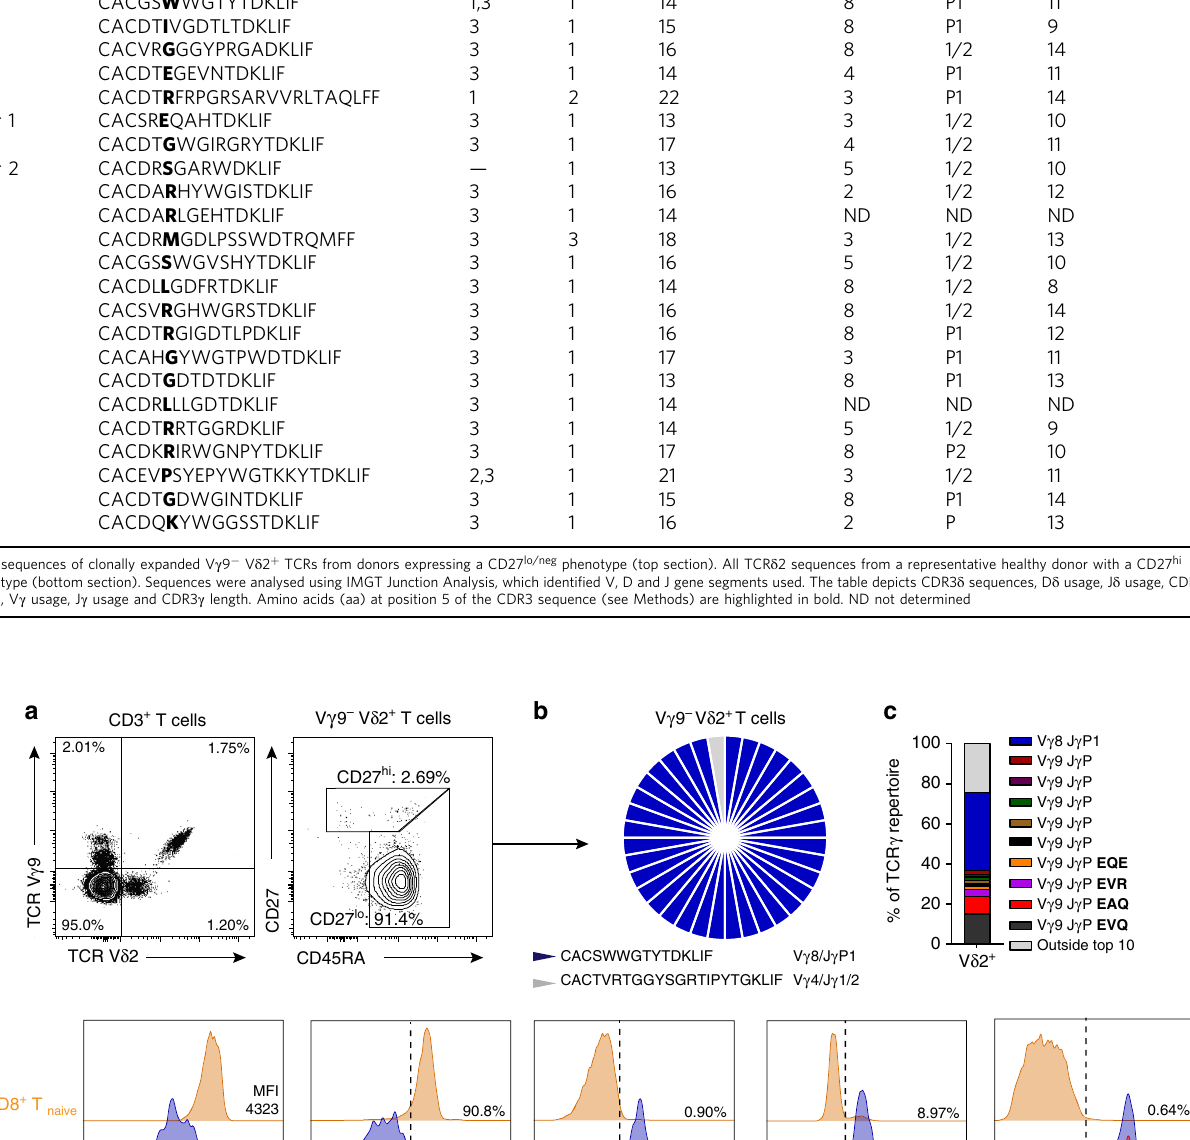
Table 2 Single-cell TCR sequencing of V γ 9 − V δ 2 + T cells Donor